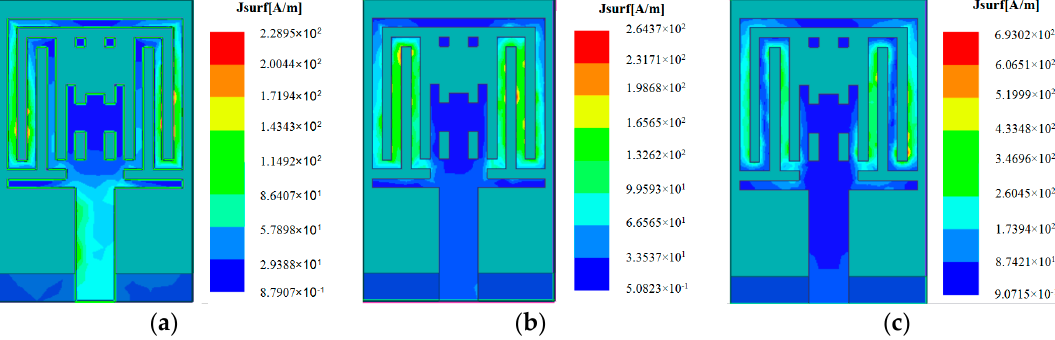
Figure 6. Simulated surface current distributions on the radiation patch for the proposed antenna at ( a ) 3.5 GHz; ( b ) 5.2 GHz; and ( c ) 5.8 GHz.